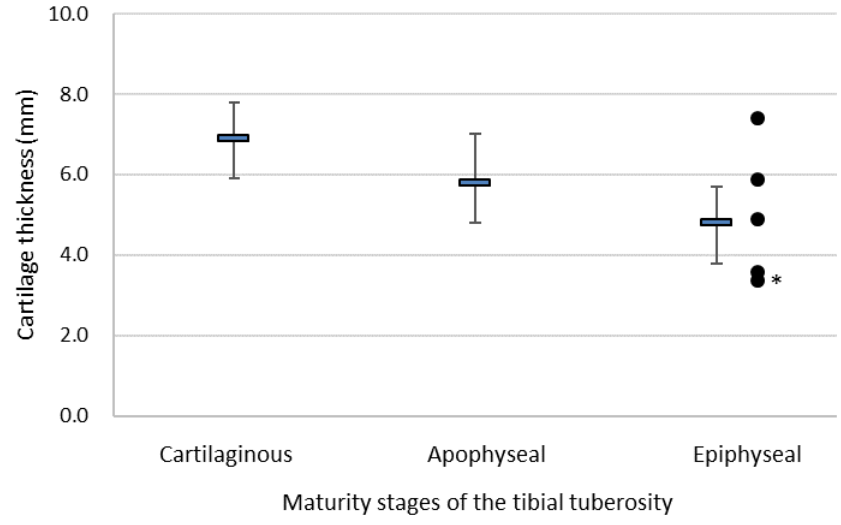
Figure 2. Scatter plot of the cartilage thickness of the tibial tuberosity of girls with Osgood–Schlatter disease (OSD) (●, n = 5) together with the mean ± standard deviation of the cartilage thickness in each maturity stage for girls. * The girl did not complain of chronic knee pain.